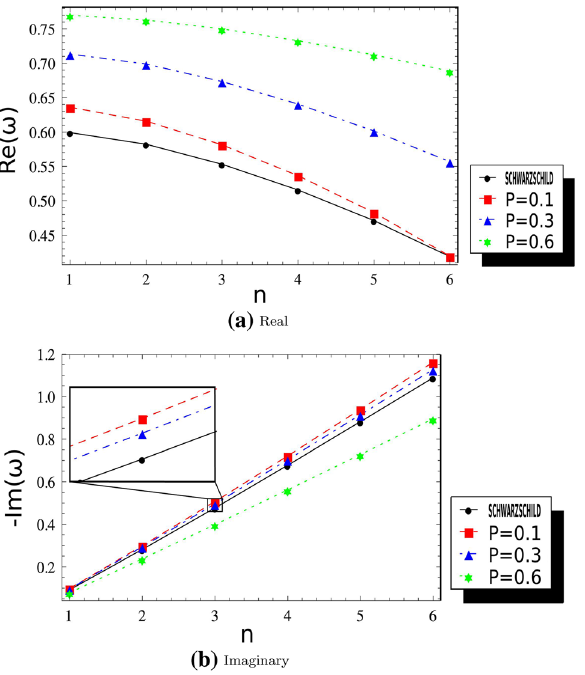
Fig. 5 Behavior of the quasinormal modes, a real part and b imaginary part of ω for l = 3 and P = 0 . 1 , 0 . 3 , 0 . 6